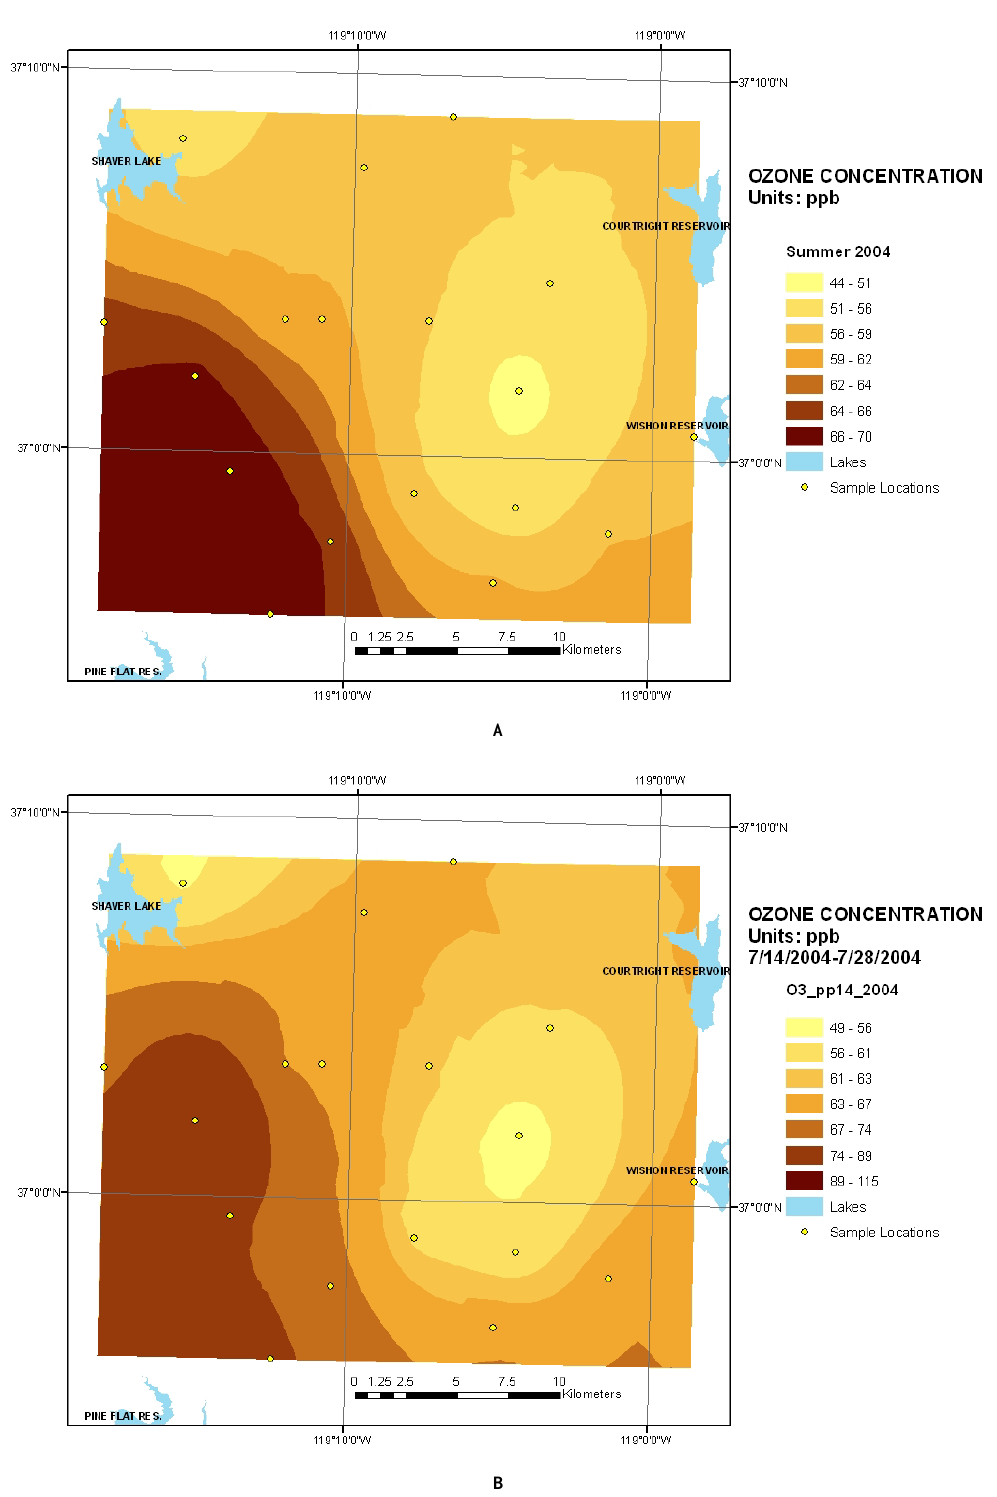
FIGURE 2 . (A) Summer season mean O 3 concentrations at the Kings River Project during 2004. (B) Two-week mean O 3 concentrations in the second half of July. (C) Summer season mean HNO 3 concentrations at the Kings River Project during 2004. (D) Two-week mean HNO 3 concentrations in the second half of July. (E) Summer season mean NH 3 concentrations at the Kings River Project during 2004. (F) Two-week mean NH 3 concentrations in the second half of